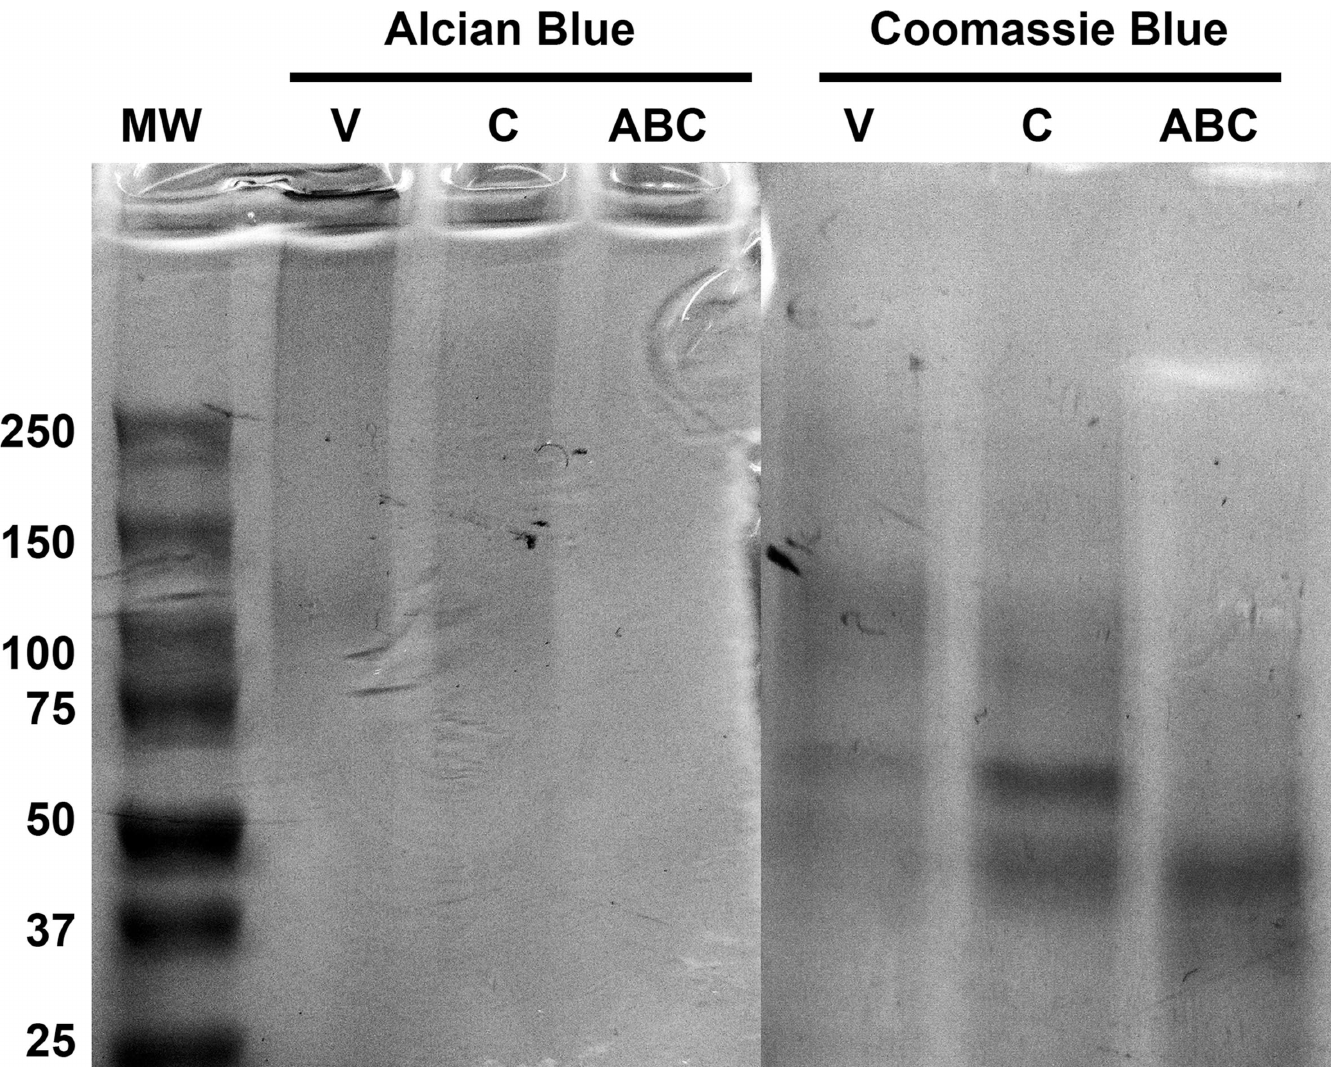
Fig 8. SDS-PAGE analysis of normal rabbit nerve proteoglycan extraction with Alcian Blue and Coomassie Blue. The proteoglycan content of 40 normal rabbit sciatic nerves were extracted and isolatedthrough DAEA column chromatography. Samples were treated with vehicle buffer (V), chondroitinase C (C), or chondroitinase ABC (ABC) and subjectedto 4–15% SDS-PAGE separation.Gels were then stainedfor Alcian Blue or Coomassie Blue to label glycosaminoglycans or protein content respectively.Vehicle treated samples resultedin a broad band when stainedwith Alcian Blue which indicatedthe presenceof glycosaminoglycanchains of various molecularmasses including three bands at the top of the gel interface, a broad band corresponding to M r = 300-450kD, and band between100 and 130kD. Coomassie Blue stainingof the corresponding column also visualizedseveralbroad bandsat lower molecularweight includingseveralstrong bandsbetweenM r = 100-130kD, 65kD, and 45-55kD.Chondroitinase C treated samples removed the Alcian Blue stained bandsat the gel interface but retainedthe bandsbetweenM r = 300-450kD and 100-130kD. Coomassie Blue stainingprovided evidenceof increasedintensity of the M r = 65kD and 45-55kDband. Chondroitinase ABC treated samples were devoid of AlcainBlue staining which indicatedthe absenceof glycosaminoglycans. Coomassie Blue stainingshoweda reductionin stainingintensity for the M r = 100-130kD and 65kD band whilethe 45-55kDband shifted downwardto aproximately 35-45kD.